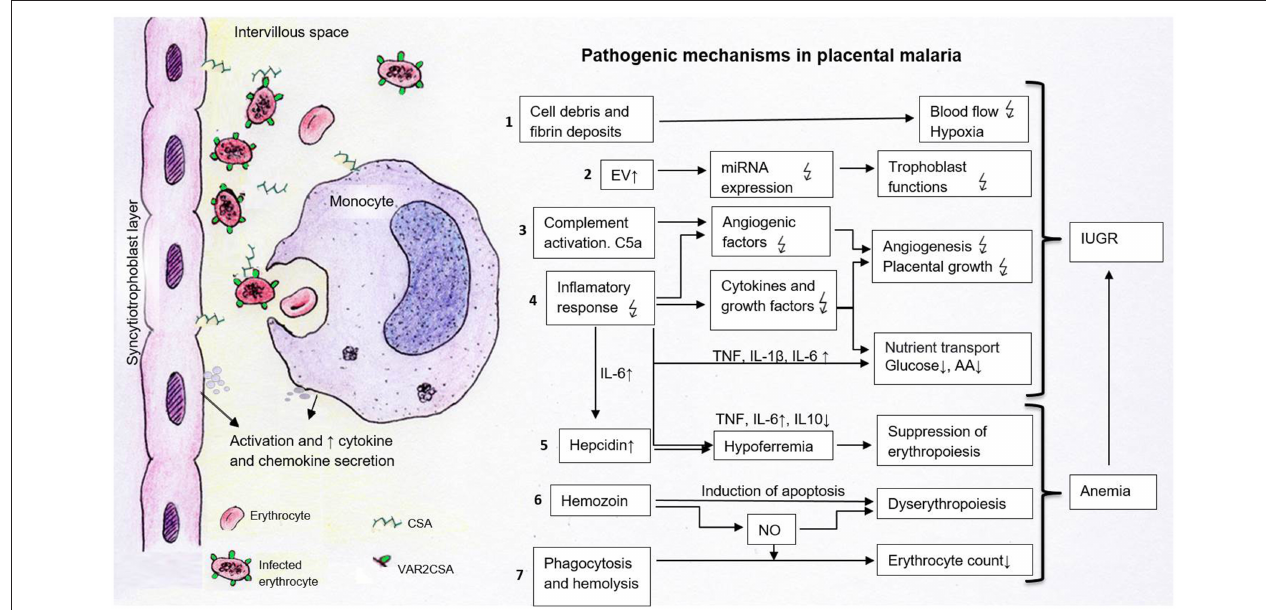
FIGURE 1 | Pathogenetic processes potentially contributing to the development of IUGR in placental malaria. The sequestration of infected erythrocytes expressing VAR2CSA in the intervillous space occurs through the binding to placental chondroitin sulfate (CSA). This process leads to the activation of syncytiotrophoblast